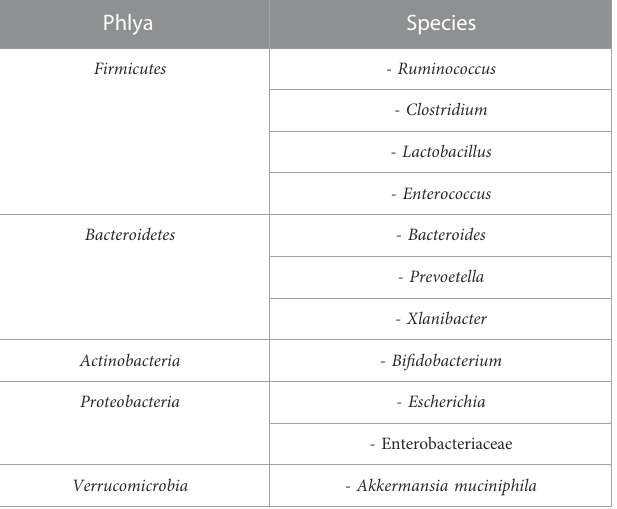
TABLE 1 Major bacterial phyla and species in human gut